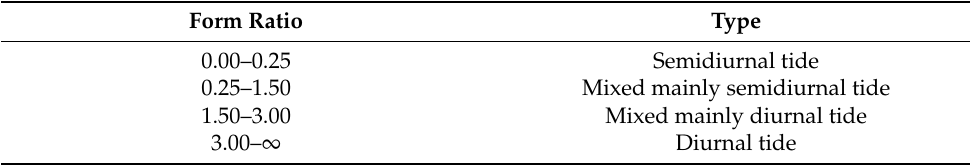
Table 5. Results of the form ratio and tidal patterns from the tide-gauge stations and HFR.